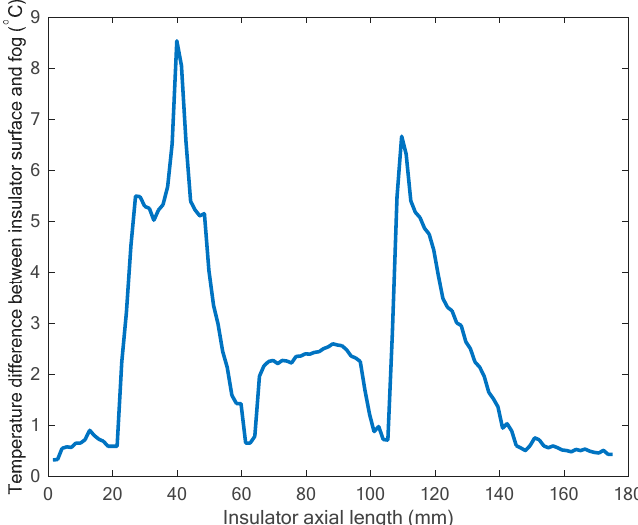
Figure 3. Temperature difference between the insulator surface and the surrounding fog.